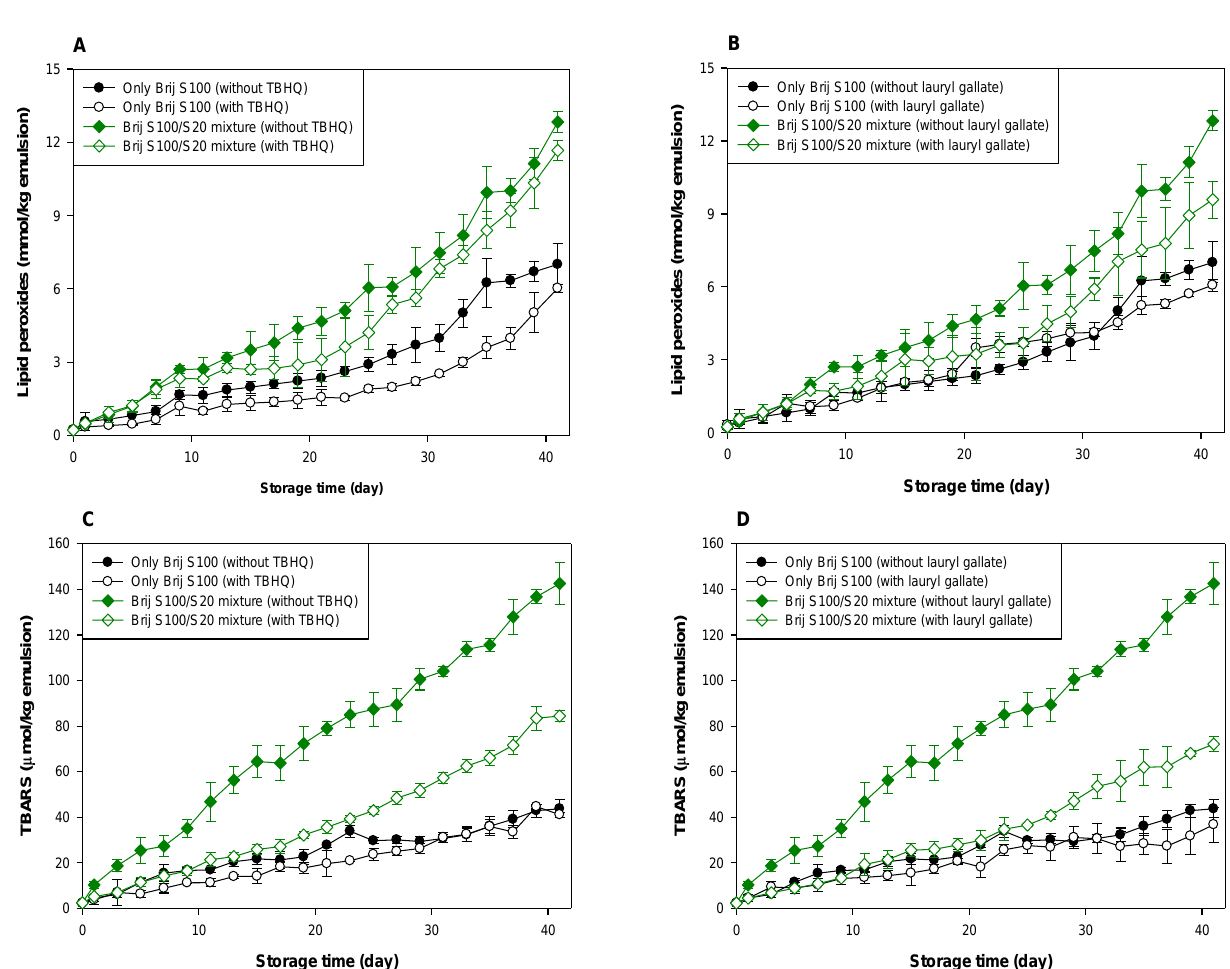
Figure 4. Effects of TBHQ ( A , C ) and lauryl gallate ( B , D ) on the evaluation of lipid peroxides ( A , B ) and TBARSs ( C , D ) in emulsions stabilized with the mixture of Brij S20 and S100 at a surfactant concentration of 1.00 mM at pH 3.